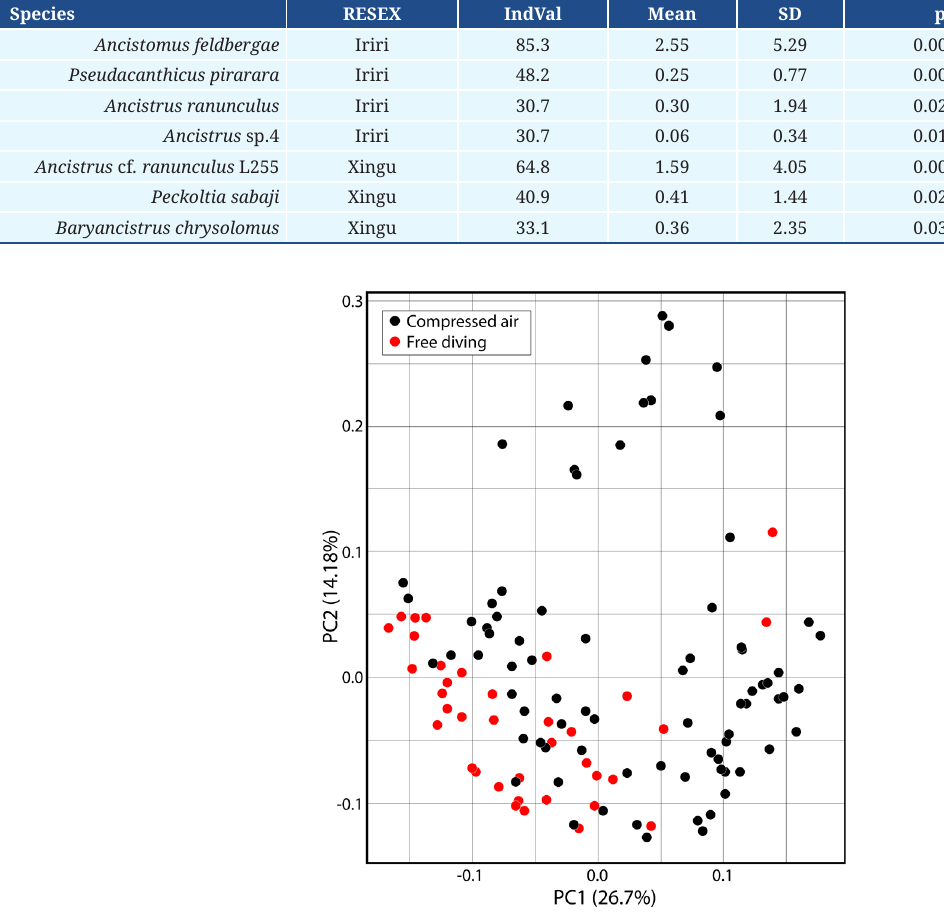
TABLE 3 | Indicator values (IndVal) of the species, taking into account drainage in the Xingu and Iriri River RESEXes.